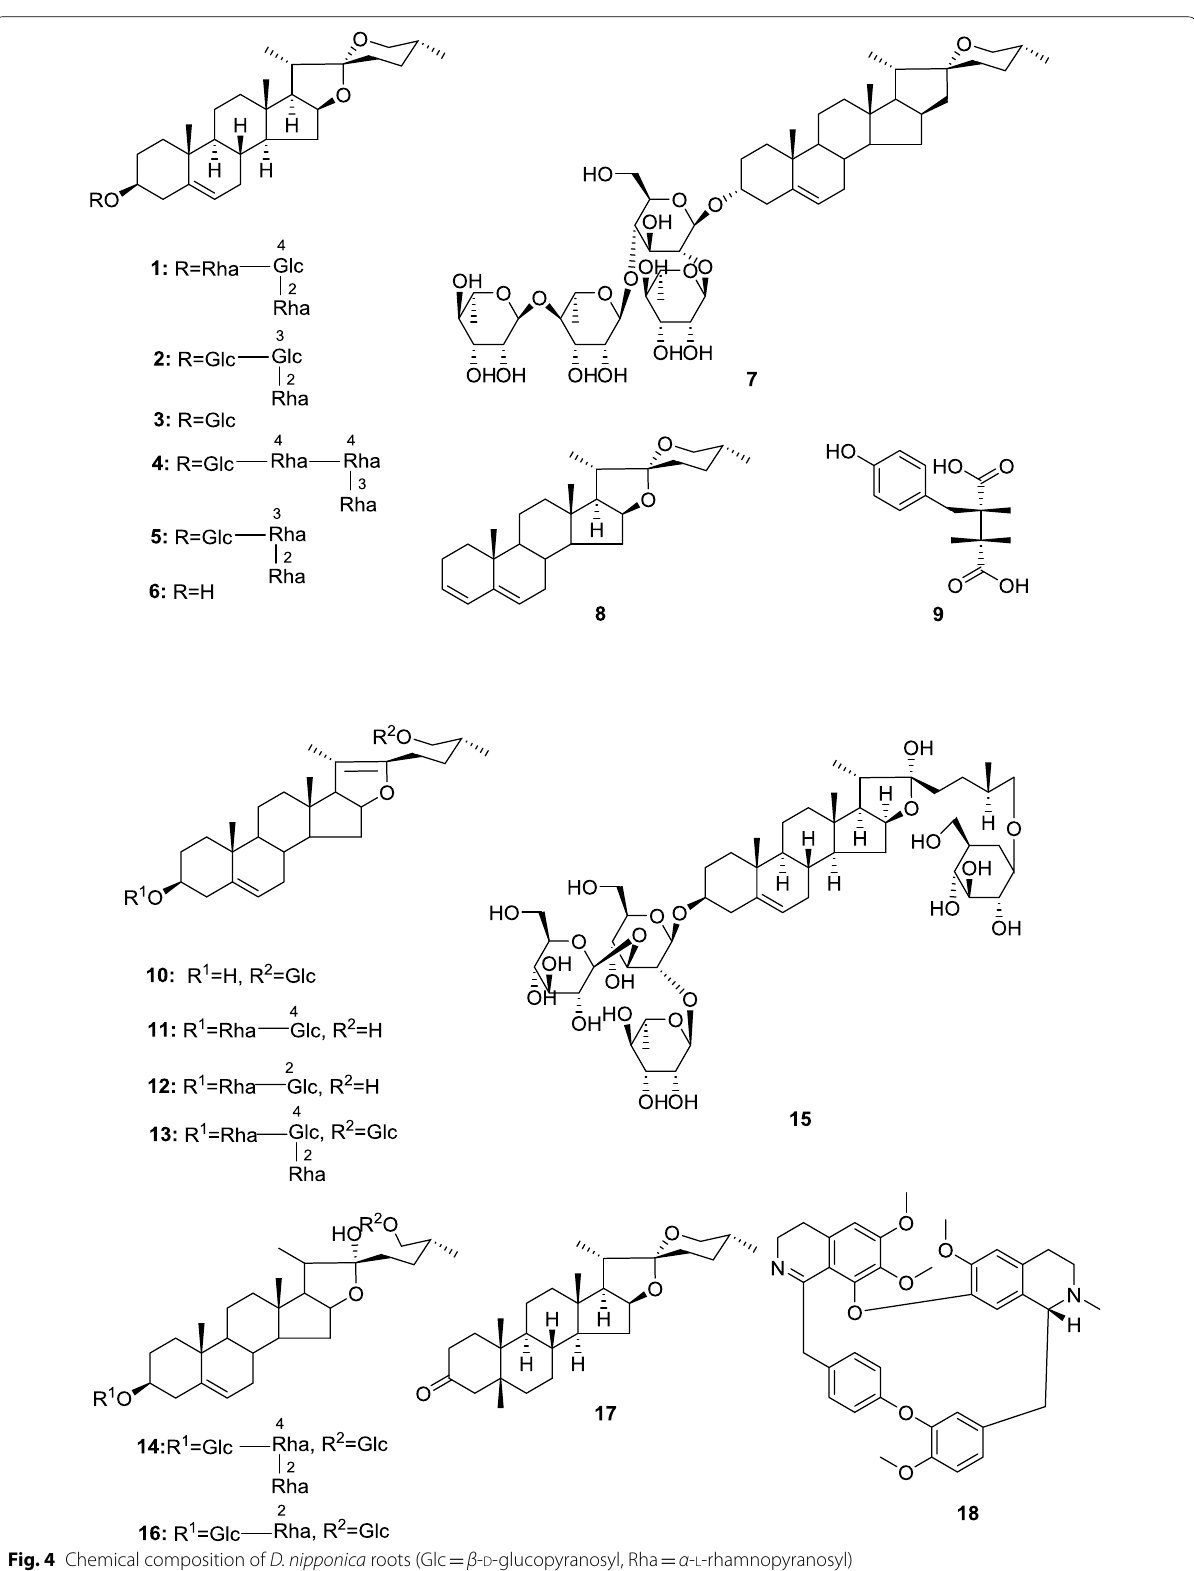
Fig. 4 Chemical composition of D. nipponica roots (Glc